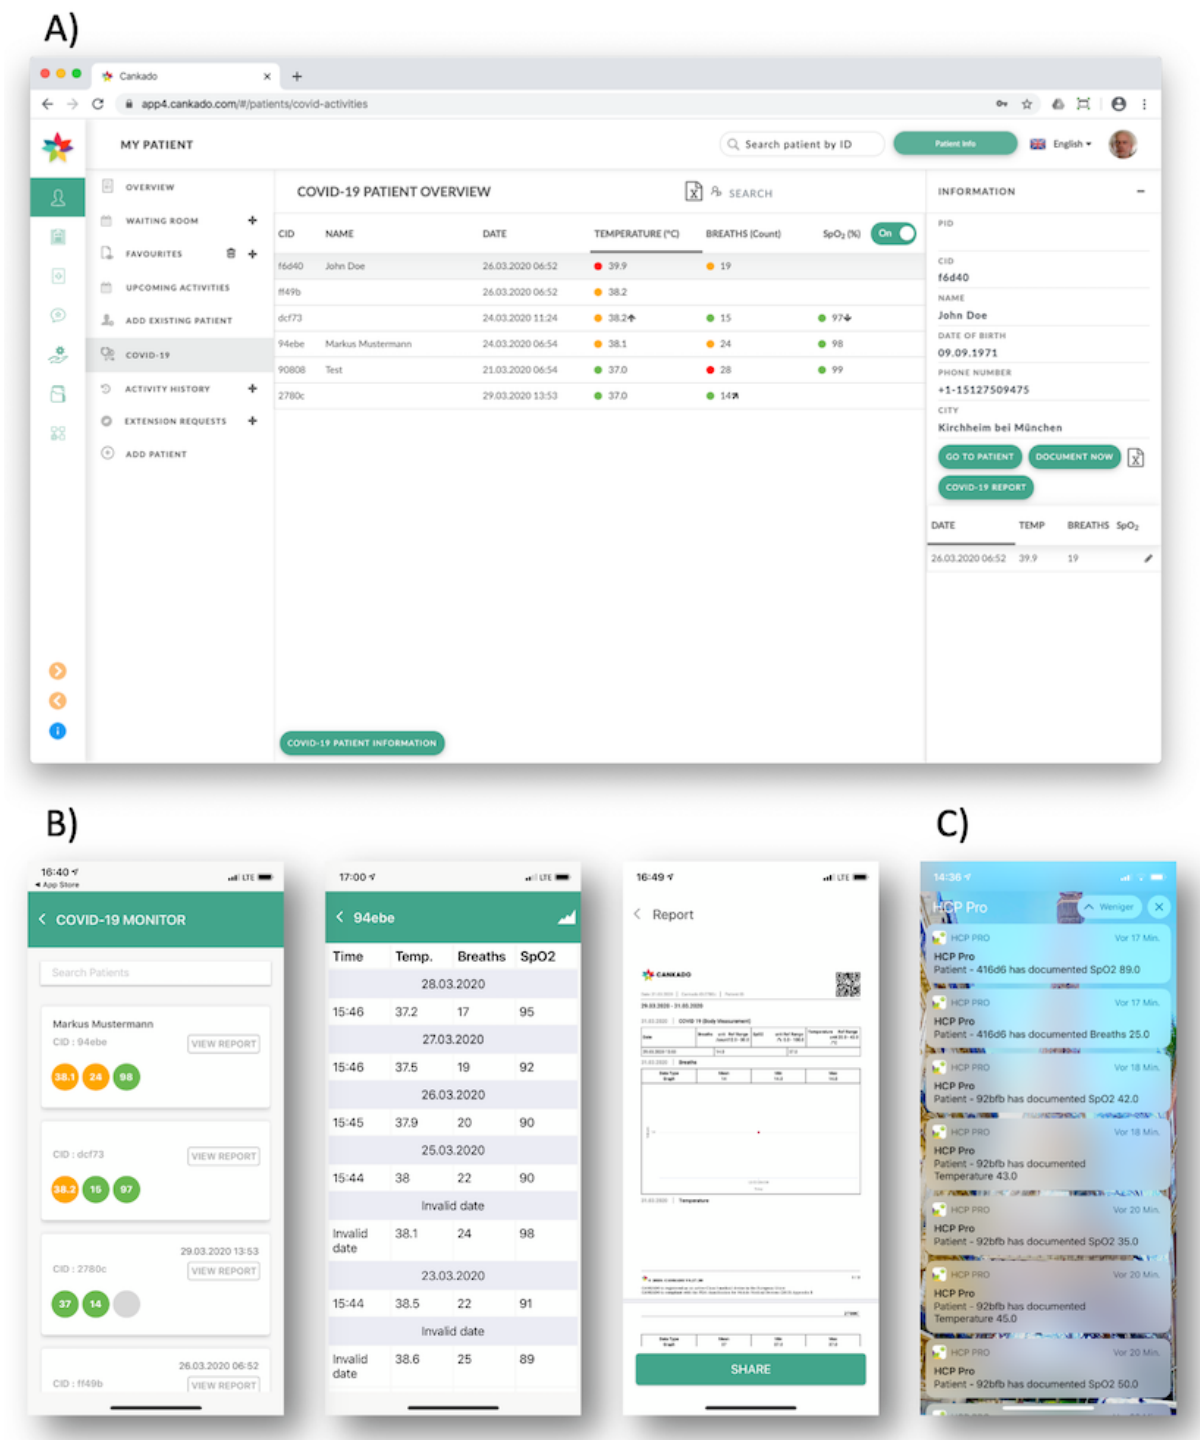
Figure 2. The COVID-19 cockpit view for health care professionals (A); patient list, patient details, and a PDF report preview using the HCP Pro